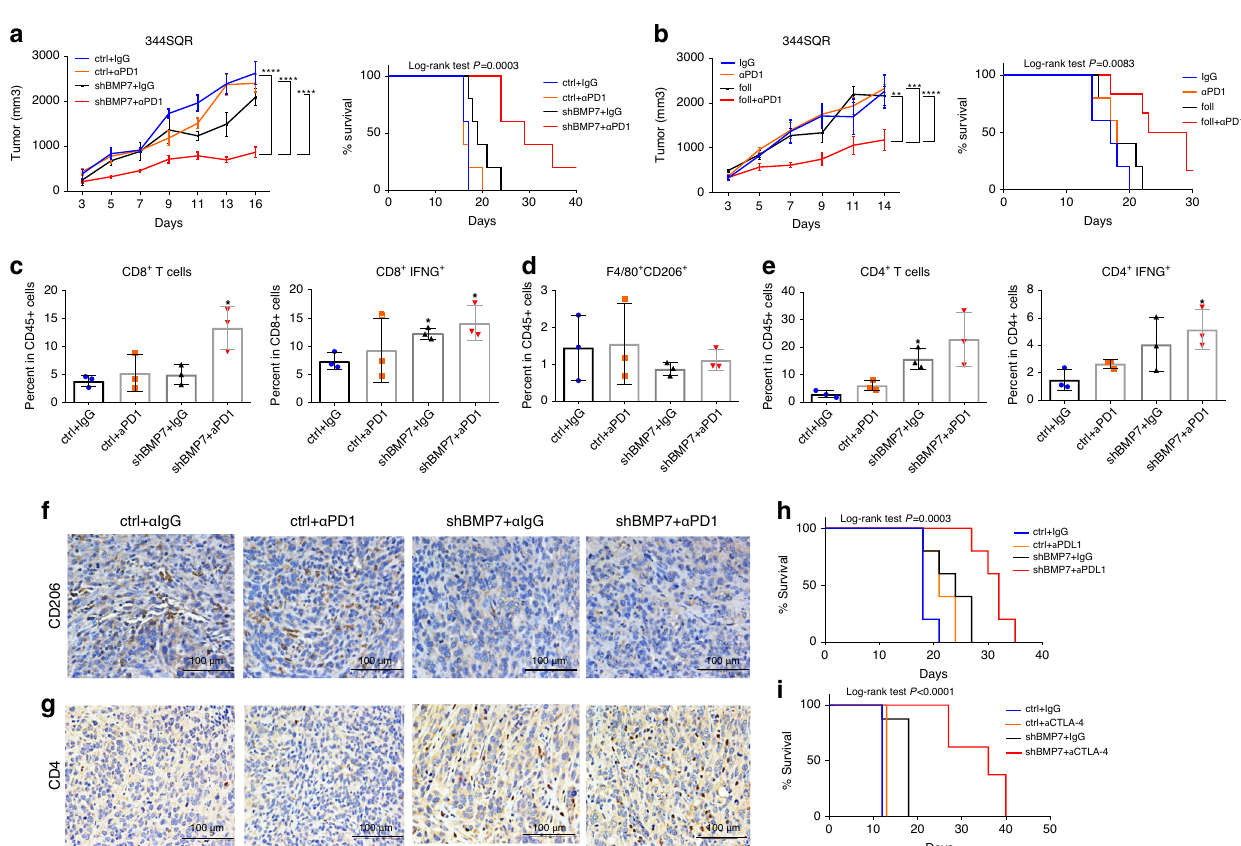
Fig. 5 BMP7 inhibition re-sensitizes resistant tumors to anti-PD1 therapy. a Tumor growth and survival analysis of mice with 344SQR tumors treated with IgG ctrl ( n = 5 animals) or anti-PD1 (10 mg/kg) ( n = 5 animals) or 344SQR shBMP7 tumors treated with IgG ( n = 5 animals) or anti-PD1 (10 mg/kg) ( n = 5 animals) twice a week for 2 weeks. b Tumor growth and survival analysis of mice with 344SQR tumors ( n = 5 animals) treated with IgG, anti-PD1 (10 mg/kg), follistatin (0.1 mg/kg), or follistatin (0.1 mg/kg) plus anti-PD1(10 mg/kg) for 2 weeks. For a, ctrl + IgG vs. shBMP7 + α PD1, **** p <